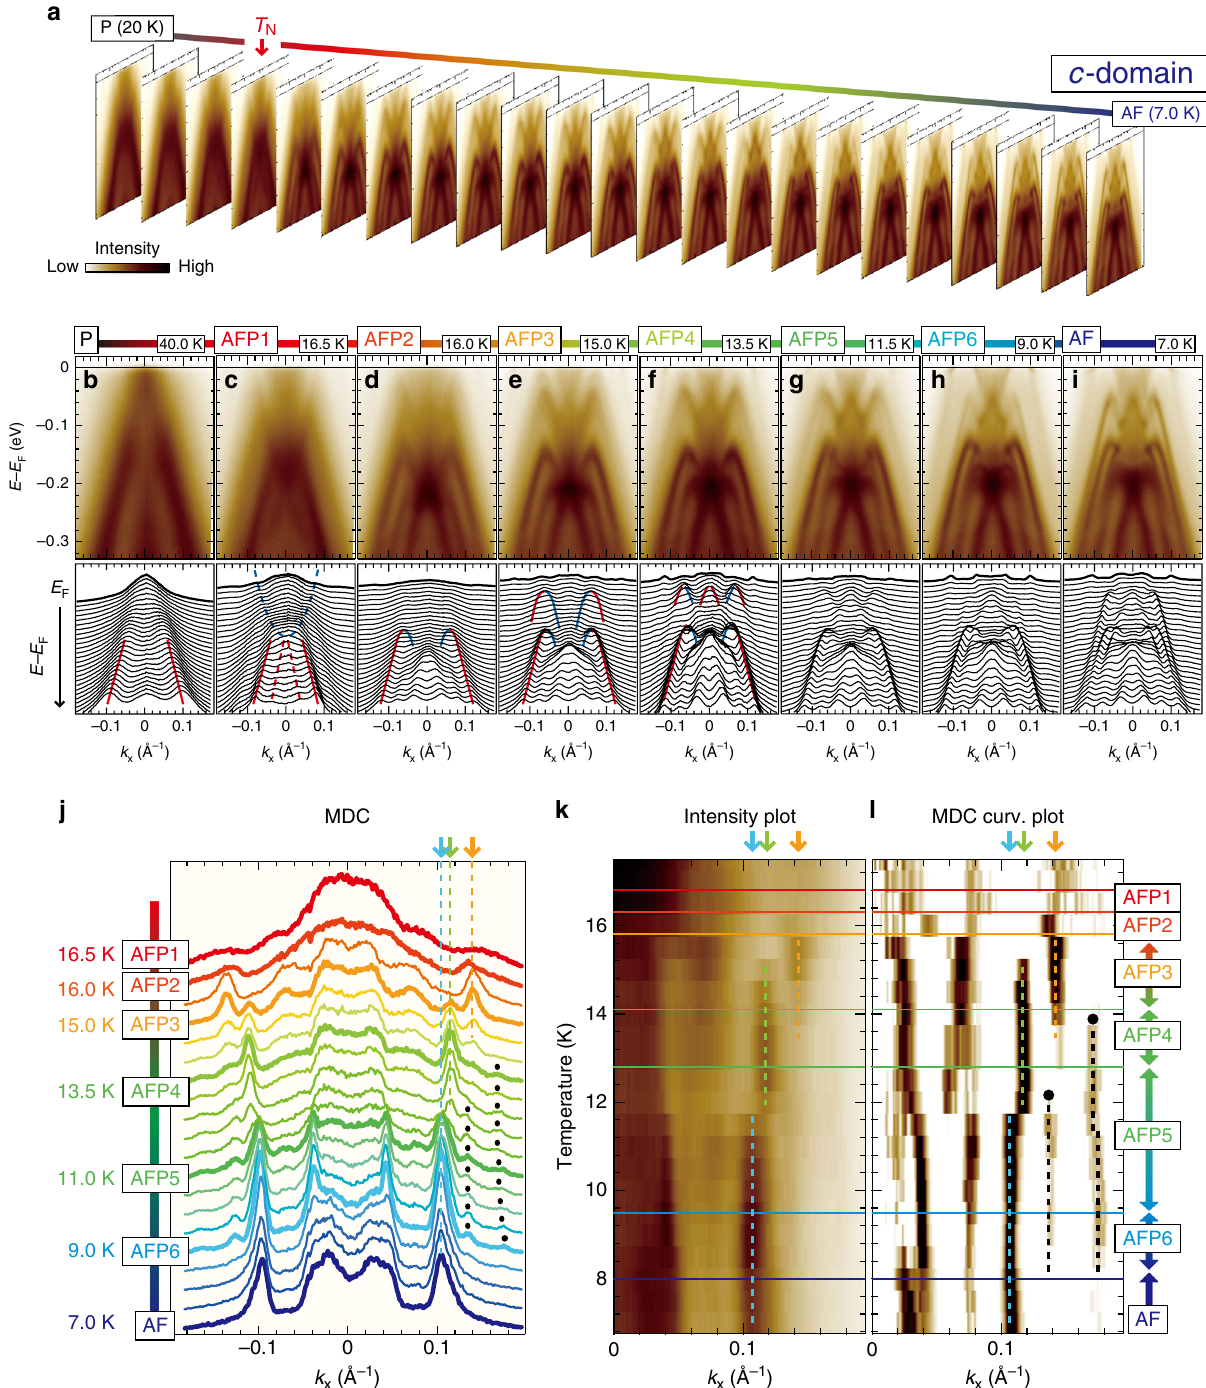
Fig. 4 Devil ’ s staircase evolution of the electronic structures. a Temperature evolution of the laser-ARPES images for c -domain from 20 K (P phase) to 7.0 K (AF phase) by a 0.5 K step (see also Supplementary Movie 1). b – i Laser-ARPES images around E F at each phase through the devil's staircase, and the corresponding momentum distribution curves (MDCs). The MDCs at E F are highlighted with bold lines. Representative changes of the band dispersions by temperature are guided by colored lines. j Temperature evolution of the MDCs at E F taken from the ARPES images shown in a . The MDCs at each phase in b – i are highlighted with bold lines. k , l Its two-dimensional map and the corresponding curvature plot 43 for k x > 0 to clearly visualize the appearances/disappearances of the quasiparticle peaks, corresponding to the devil's staircase transitions. The colored solid lines are the transition temperatures previously determined by speci fi c heat measurement 10 . The colored arrows, circles, and dashed lines indicate the representative peaks in the different